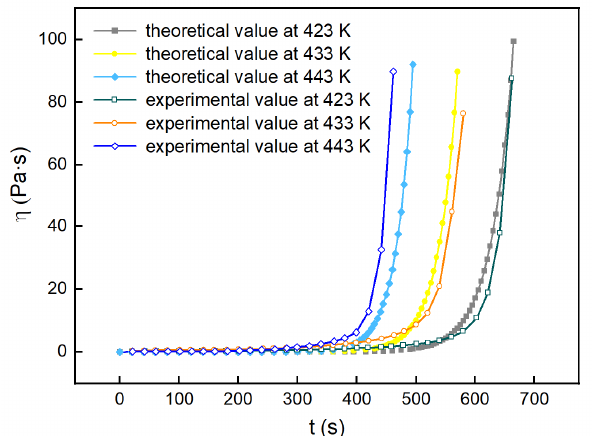
Figure 21. Theoretical and experimental viscosity curves of the H 6 XDI/BES system at different tem- peratures.